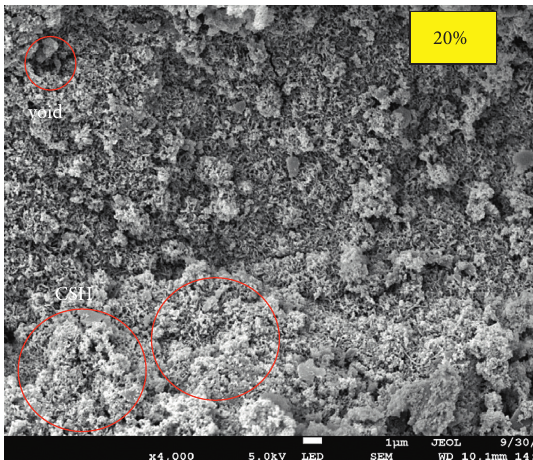
Figure 9: Specimen containing 20% spent garnet with lesser amount of